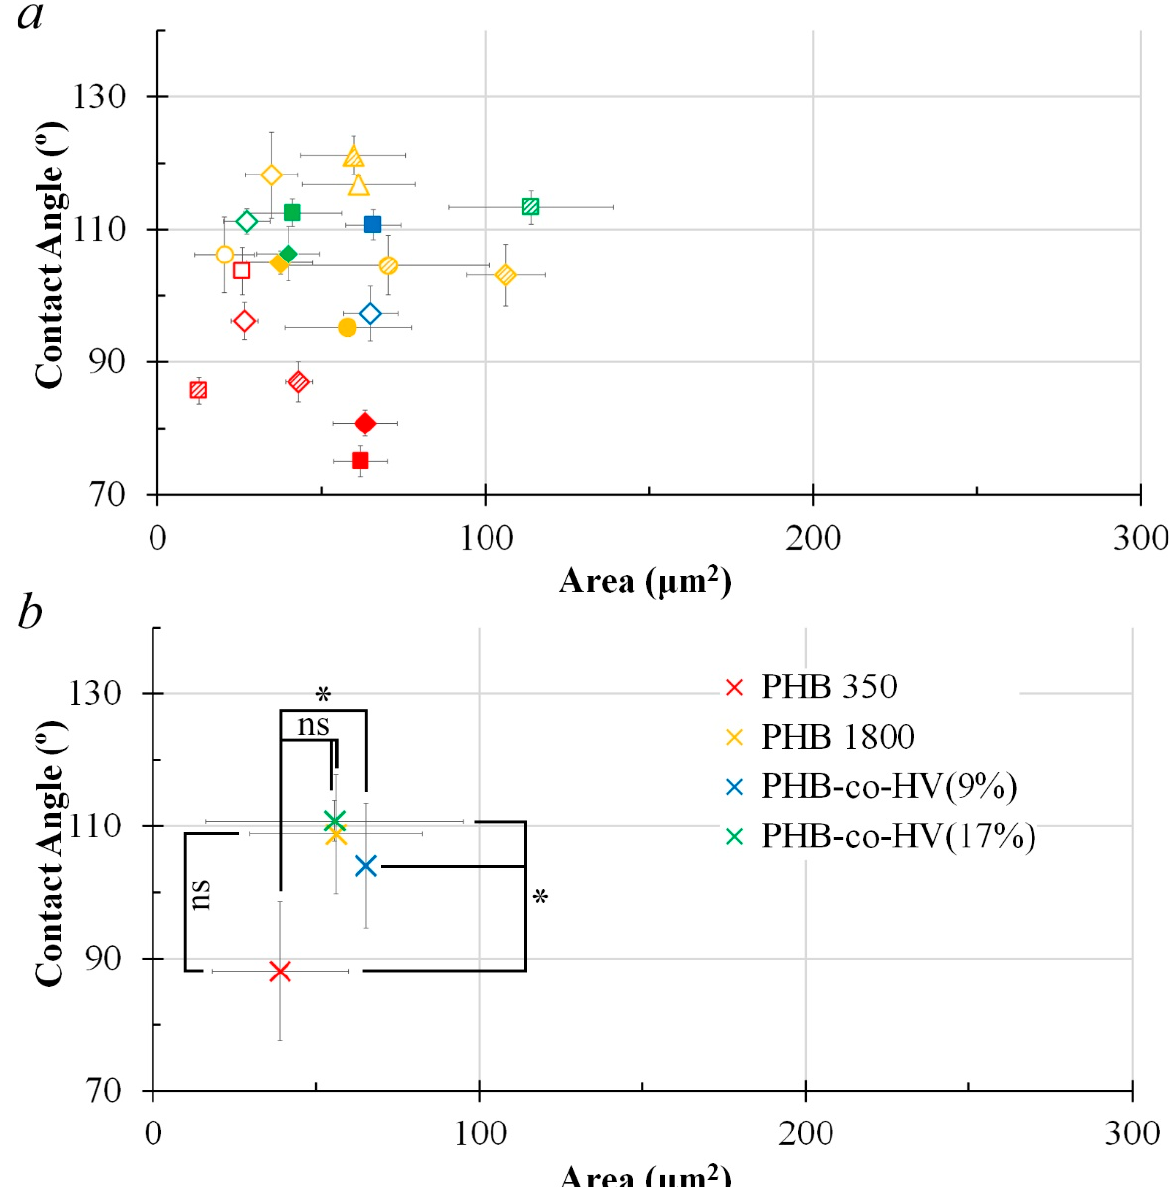
Figure 9. Area vs. Contact Angle plot of structural elements based on their respective concentrations and volumes (150 μ L, 300 μ L, 450 μ L) with the distance L = 1 cm (n = 13). Legends: Polymers: red—PHB 350 kDa; yellow—PHB 1800 kDa; blue—PHB- co -HV (9%); green—PHB- co -HV(17%). Concen- tration: ◯ —5 mg/mL; △ —10 mg/mL; ◇ —20 mg/mL; □ —40 mg/mL. Volume: blank marker—150 μ L; shaded marker—300 μ L; filled marker—450 μ L ( a ). Average data for each polymer group PHB350, PHB1800, PHB- co -HV(9%), PHB- co -HV(17%), n = number of data points for each polymer type; * ( p < 0.05 vs. PHB350) or ns ( p > 0.05 vs. PHB350) for polymer groups representing area and contact angle, the Kruskal–Wallis one-way ANOVA test for more than 2 independent groups ( b ).